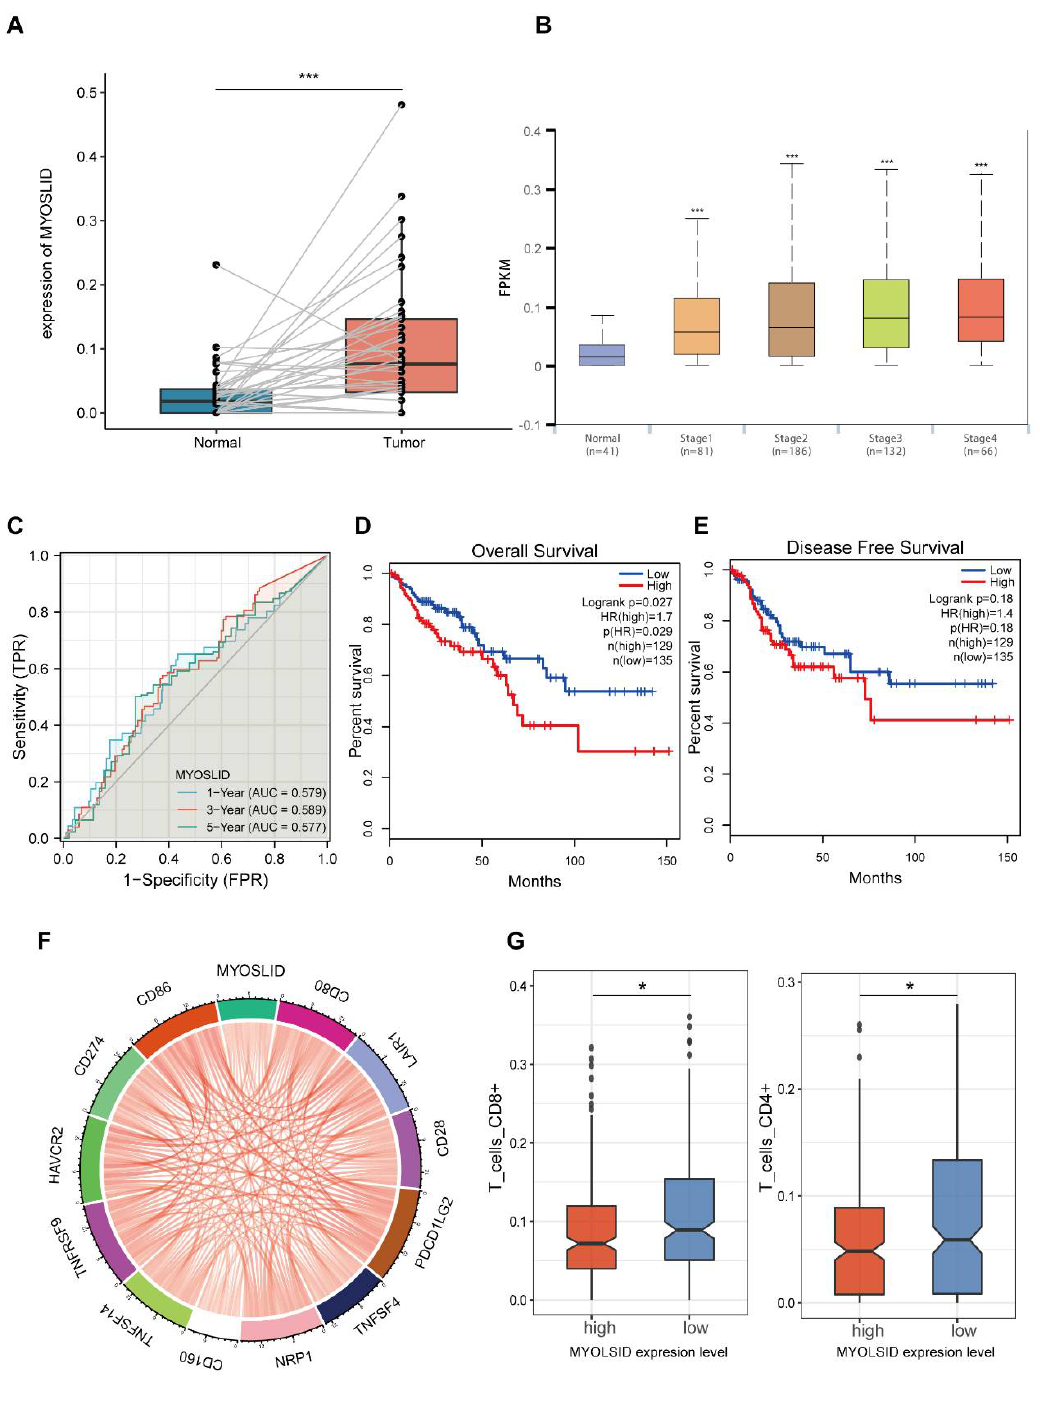
Figure 9. The expression and prognostic value of LncRNA MYOSLID and its association with immune infiltration in CRC patients. ( A ) The expression level of MYOSLID in CRC tissues and in pericarcinous tissues was investigated using datasets from the TCGA database. ( B ) MYOSLID expression levels in patients at different CRC stages. ( C ) The time − dependent ROC curve illustrates the potential use of MYOSLID in predicting the 1-, 3-, and 5-year overall survival rates of CRC patients. ( D , E ) The K–M analysis shows the correlation between MYOSLID expression level and the OS and DFS of CRC patients from the TCGA database. ( F , G ) The difference between the MYOSLID expression level and the levels of infiltrating CD4 + T/CD8 + T cells in CRC patients. *: p < 0.05, ***: p < 0.001, ns: no